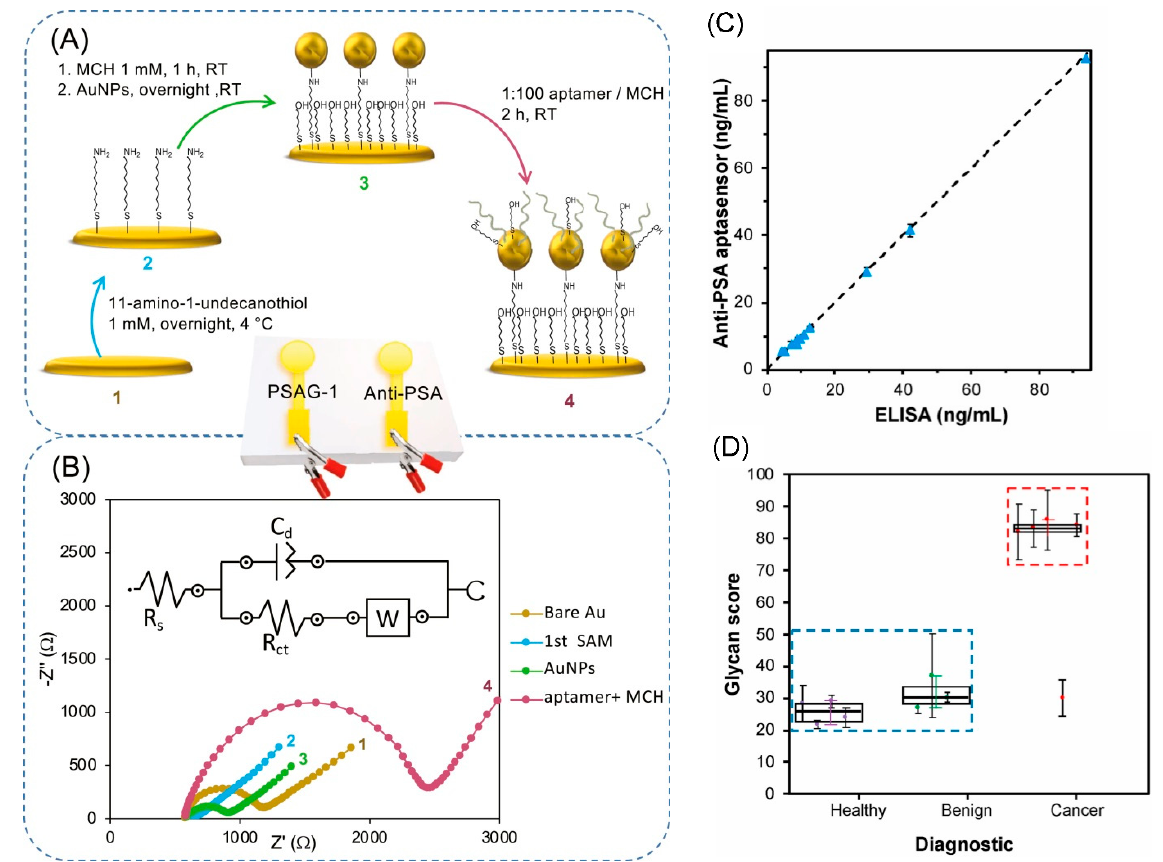
Figure 20. ( A ) Steps involved in the construction of the dual impedimetric aptamer-based platform for the sequential measurement of PSAG-1 reactive PSA and total PSA. ( B ) Nyquist plot recorded in a PBS solution with 5 mM [Fe(CN)6]3-/4- during the stepwise aptasensors fabrication. The inset shows the Randles equivalent circuit used to fit the experimental data. Results of the analysis of serum samples with the impedimetric dual-platform. ( C ) Correlation between total PSA serum levels found by a standard ELISA and those obtained with the anti-PSA aptamer-based sensor. ( D ) Correlation between the glycan score, obtained as the ratio between PSAG-1 reactive PSA and total PSA, and the diagnosed pathology. Reprinted from ref. [201]. Copyright (2021) with permission from Elsevier.